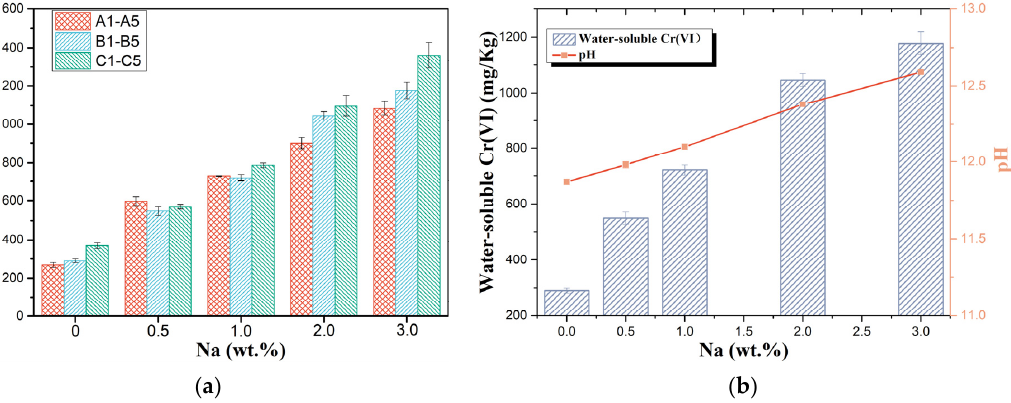
Figure 4. ( a ) Cr(VI) leached from samples A1–A5, B1–B5, and C1–C5, and ( b ) water-soluble Cr(VI) of samples B1–B5 and pH in the filtrates of samples